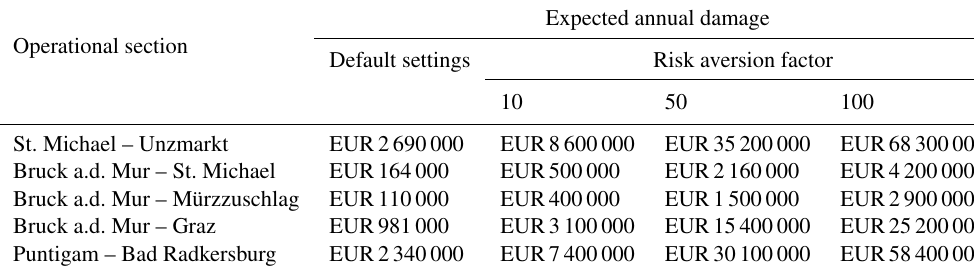
Table 4. Expected annual damage for operational sections and for varying risk aversion